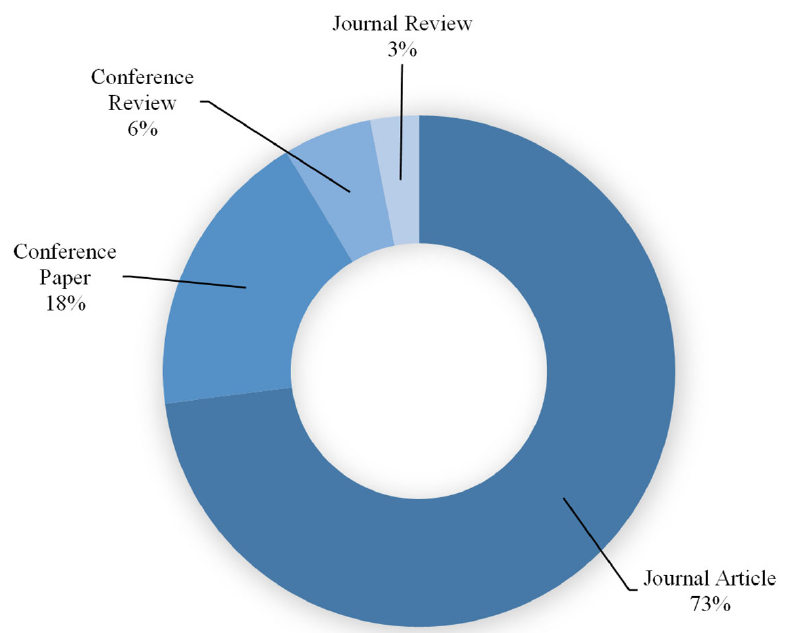
Figure 3. Kinds of documents available on FRGP